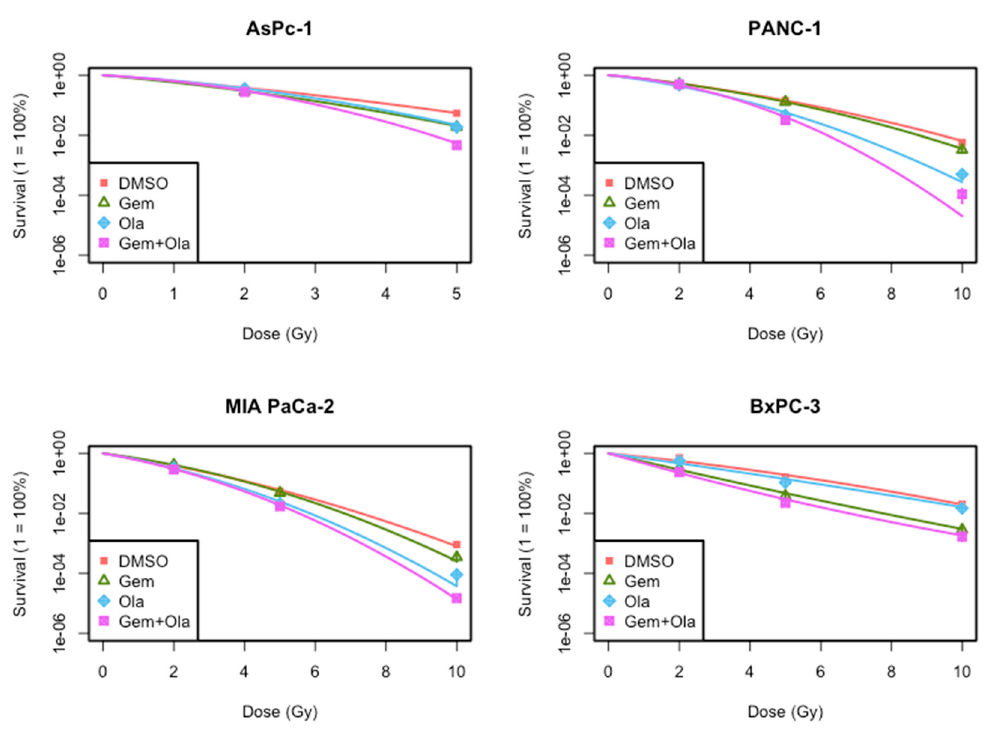
Figure 4. Clonogenic survival curves presenting surviving fractions of PANC-1, AsPC-1, MIA PaCa-2 and BxPC-3 cell lines treated with gemcitabine (Gem, 10 nM), olaparib (Ola, 1 µM) or the association of gemcitabine and olaparib (Gem + Ola). Table 2. Values of linear quadratic parameters ( α and ß) and standard enhancement ratio (SER) from PDAC cells treated with ionizing radiation and olaparib and/or gemcitabine. Statistical sig-